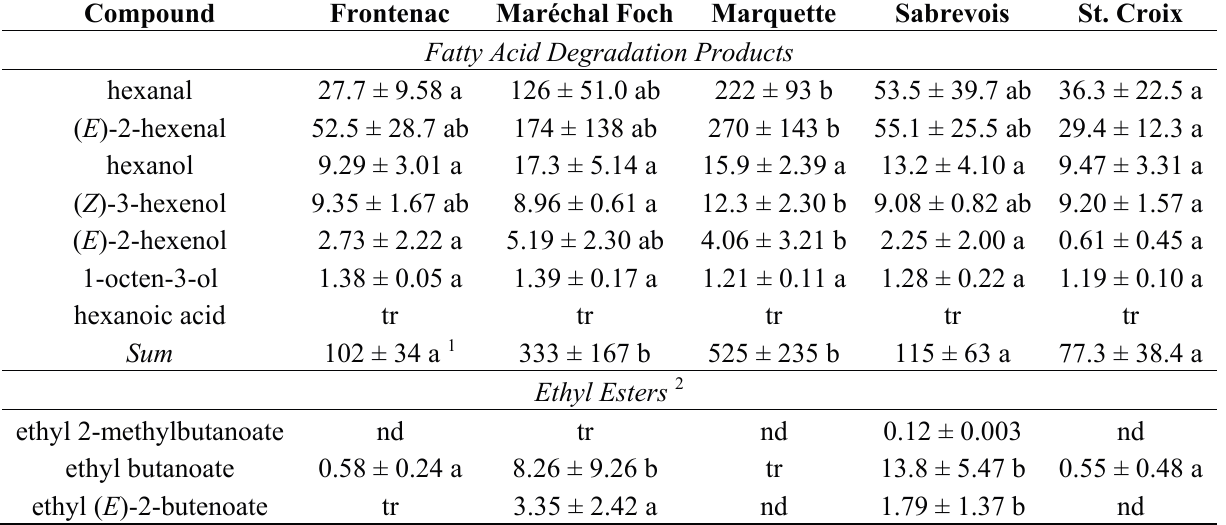
Table 3. Free volatile compounds ( μ g/kg berry) from berry skin of the interspecific hybrids Frontenac, Maréchal Foch, Marquette, Sabrevois, and St. Croix harvested in the province of Québec (Canada), during the season